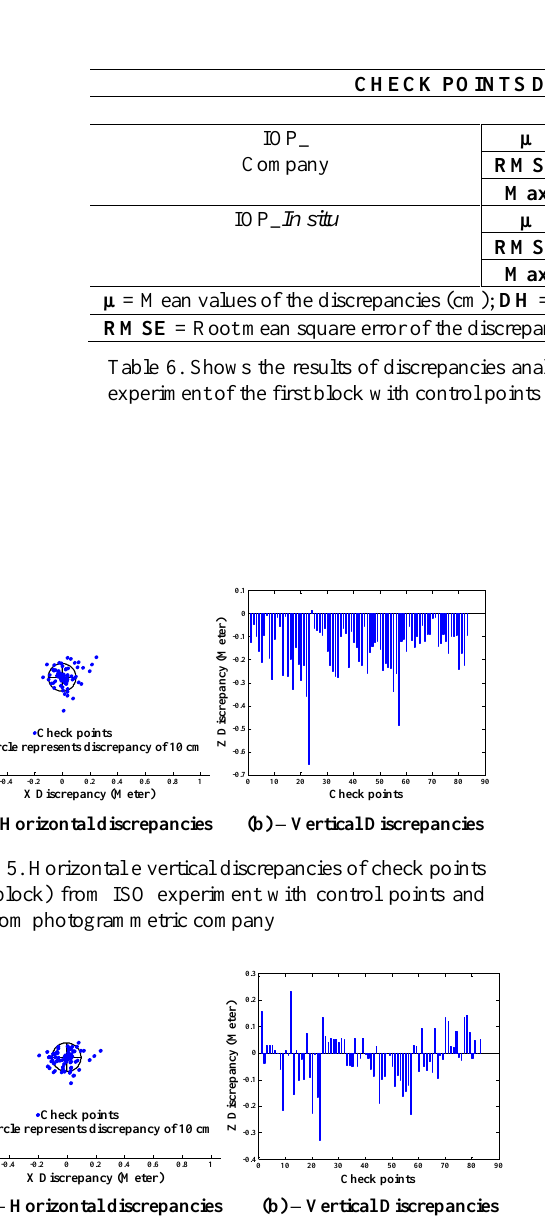
Figure 6. Horizontal e vertical discrepancies of check points (first block) from ISO experiment with control points and IOP from in situ calibration